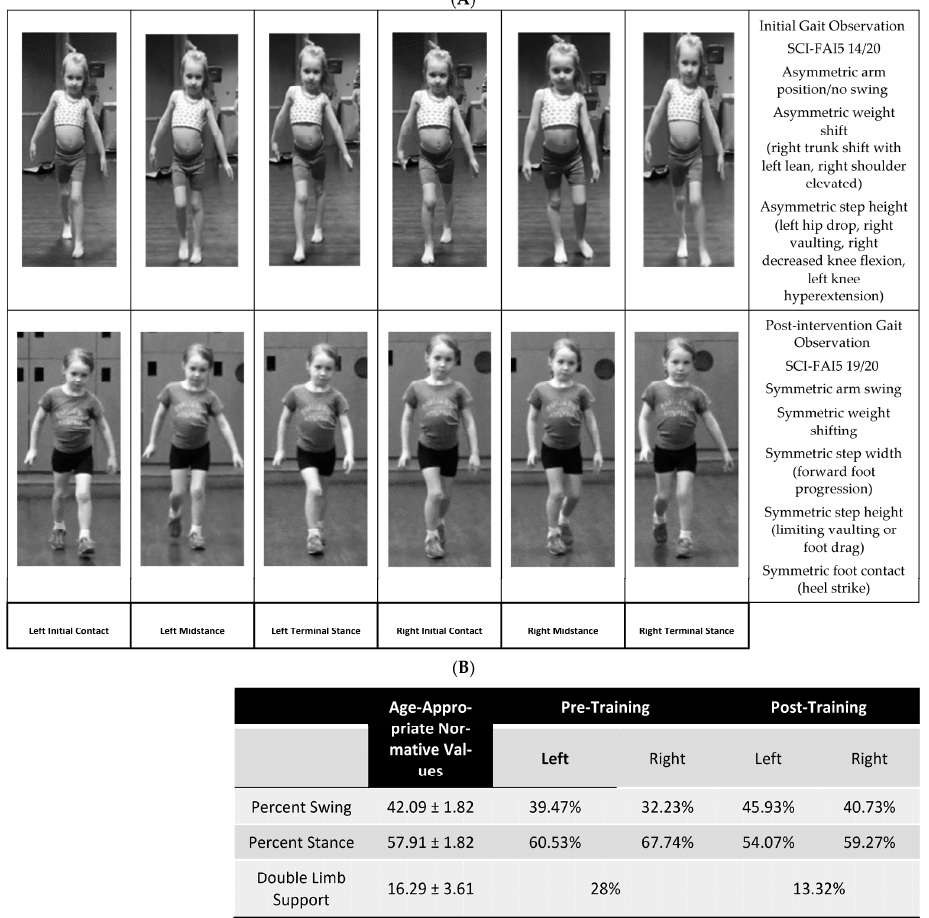
Figure 4. ( A ) Observational change in gait pattern symmetry and objective changes captured by SCI ‐ FAI from initial evaluation through discharge evaluation. SCI ‐ FAI = Spinal Cord Injury Func ‐ tional Ambulation Index. ( B ) Percentages of swing and stance phases before and after treatment compared to age ‐ appropriate normative values from Voss et al. 2020 [29]. Follow ‐ up evaluation: A follow ‐ up evaluation was performed five months post ‐ dis ‐ charge (Figure 2B). At the follow ‐ up evaluation, the family reported that at 1 ‐ month post ‐ discharge, there had been increased falls, and the child had subsequently undergone de ‐ tethering surgery.